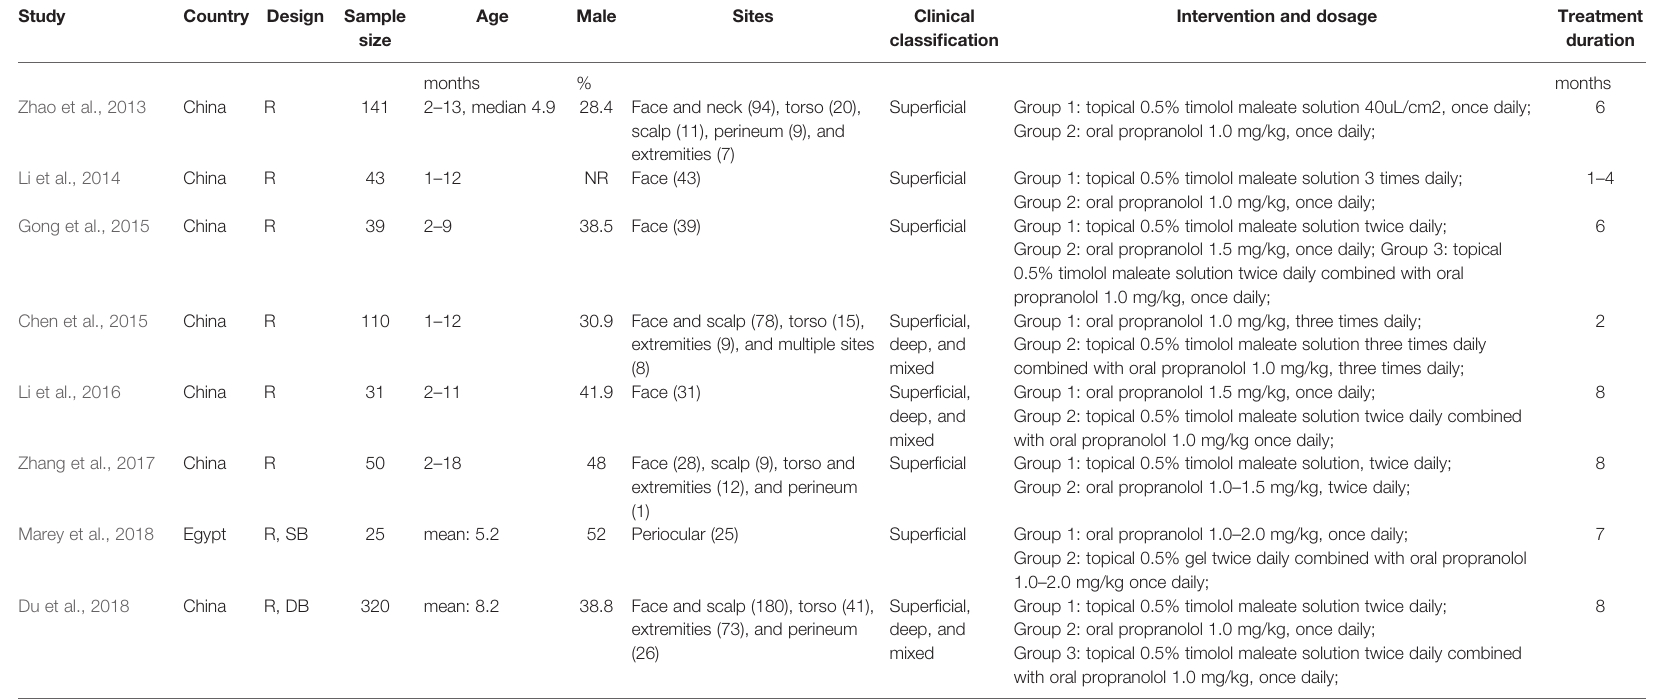
TABLE 1 | Characteristics of the included